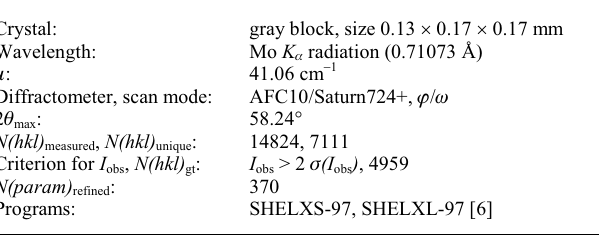
Table 1. Data collection and handling.